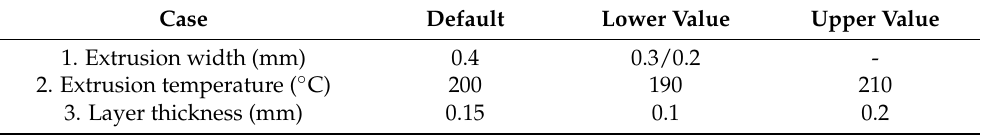
Table 7. Parameters for testing